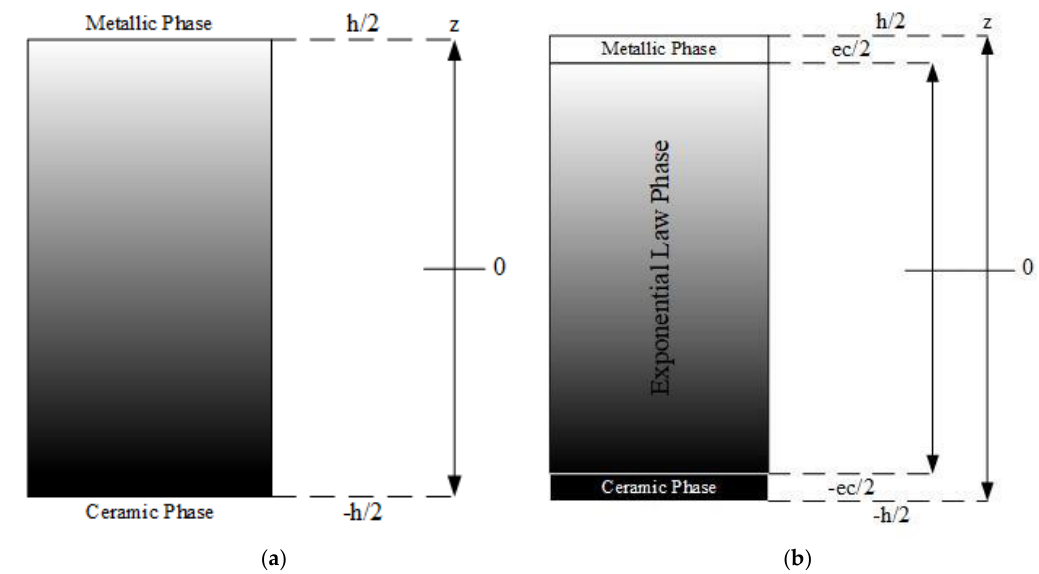
Figure 1. Schematic representation of the material phases mixture through the composite thickness, according to ( a ) the power exponent law and ( b ) exponential law.